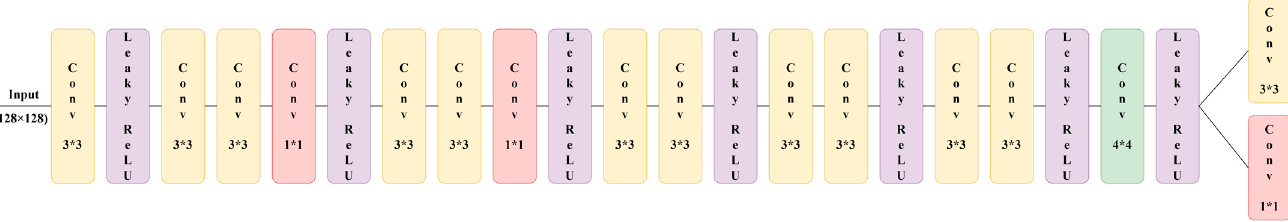
Figure 2. The architecture of the generator.